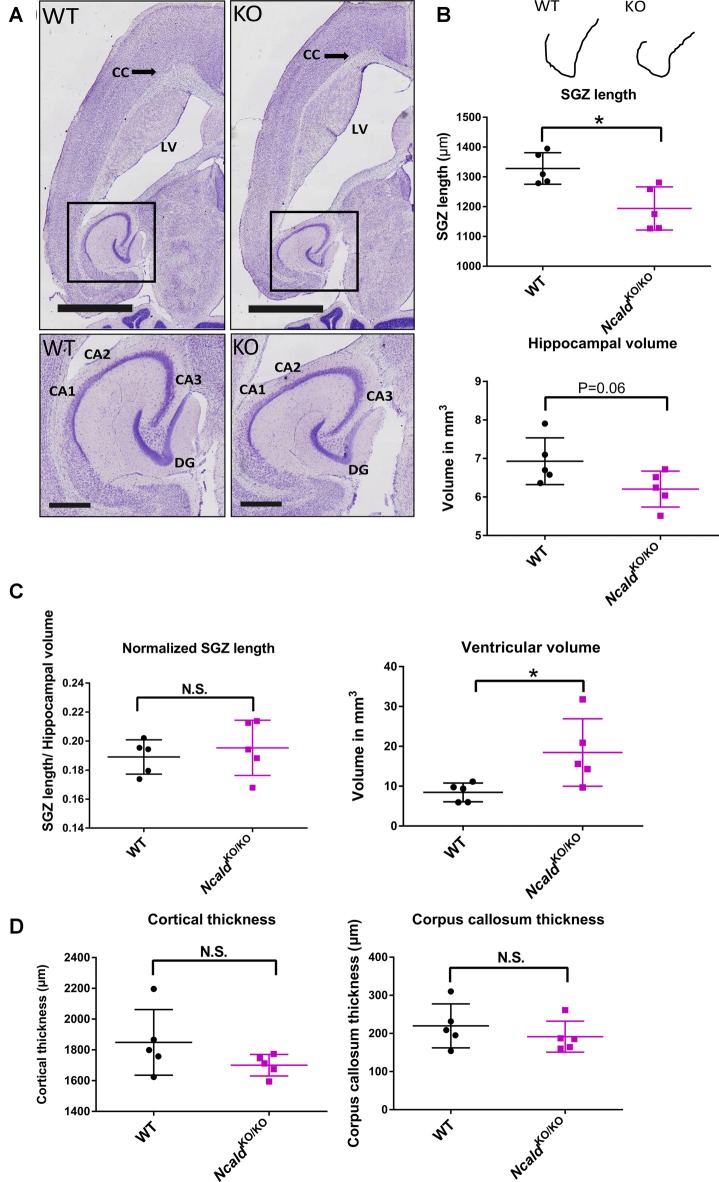
NcaldKO/KO mice exhibit abnormal brain gross morphology when compared to WT littermates. (A) Representative examples of Nissl-stained 4-month-old NcaldKO/KO and WT brains; scale bars 2 mm and 500 μm (magnified inset). (B) Schematic illustration of a tracing line used to manually measure the subgranular zone (SGZ) length on Nissl-stained consecutive brain section. Dot plots representing a reduction in the SG length (SGL) of the dentate gyrus (DG) and a strong tendency towards a smaller hippocampal volume in NcaldKO/KO mice compared to WT littermates; N = 5; *P < 0.05. (C) Dot plots representing no significant difference in the SGL, when normalized to the hippocampal volume and significantly increased volume of lateral ventricles in NcaldKO/KO mice compared to WT littermates; N = 5; *P < 0.05; N.S. = not significant. (D) Dot plots representing unaltered cortical thickness and corpus callosum thickness in the NcaldKO/KO animals in comparison to WT littermates; N = 5; N.S. = not significant.